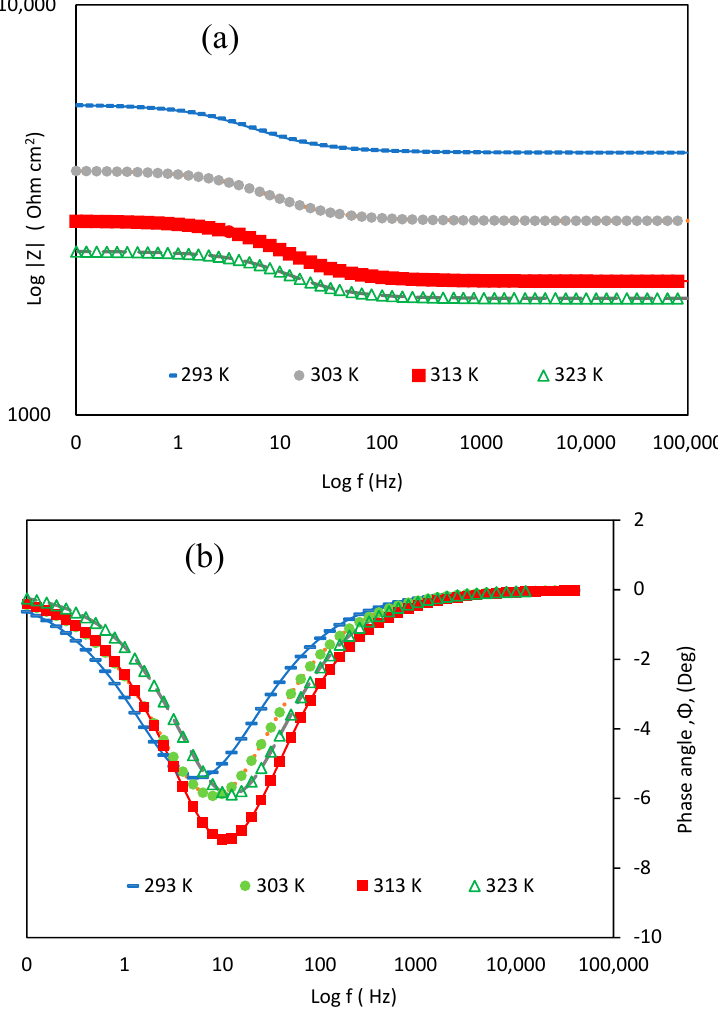
Figure 5. Bode curves of ( a ) phase angle vs frequency, and ( b ) modulus vs frequency. for API X-120 steel alloy in GTL process water solution experimentally (point line) and fitted (solid lines) at different temperatures.